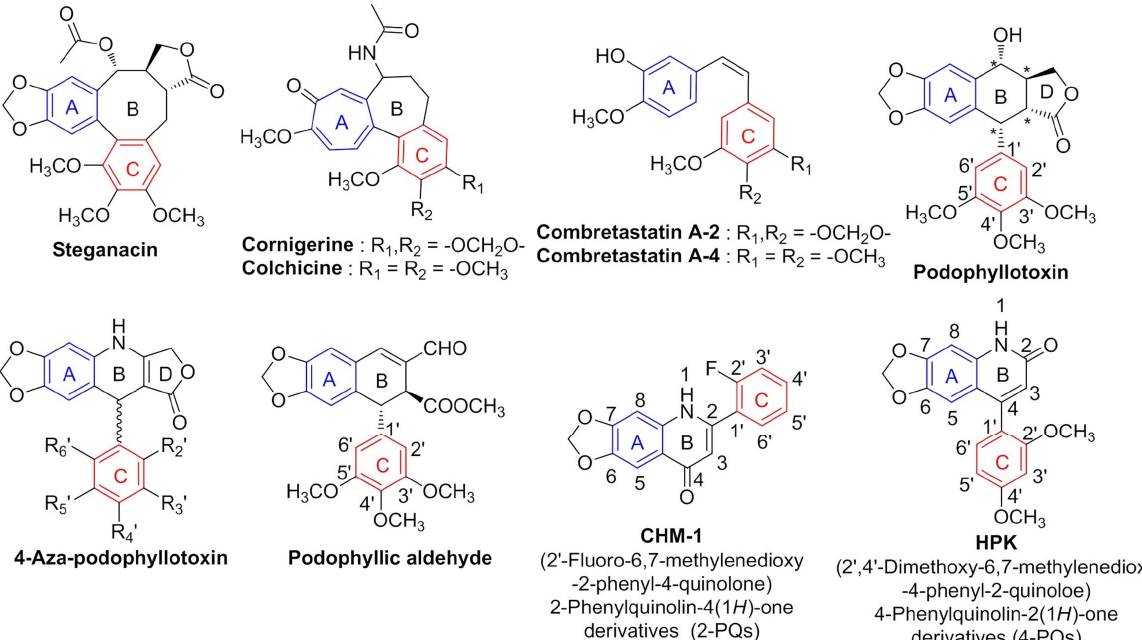
Figure 1. Structures of antimitotic agents, * = Chiral carbon centers.